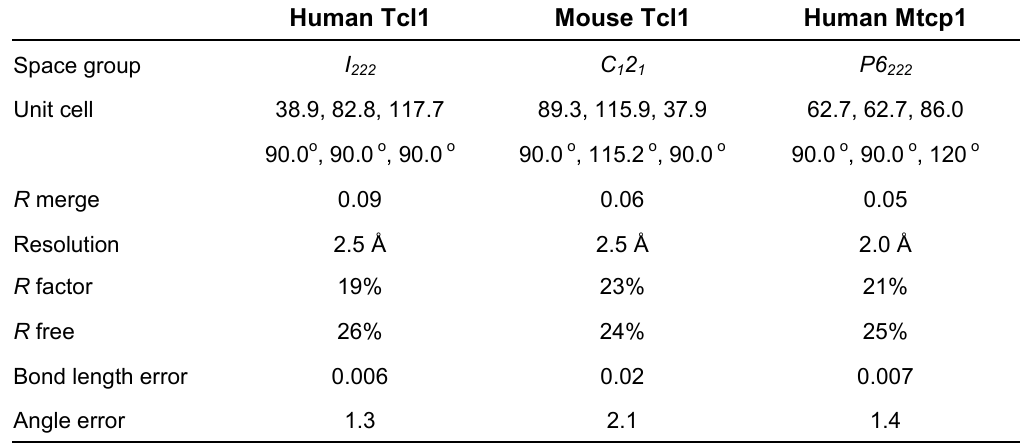
Crystallographic Statistics for Human Tcl1, Mouse Tcl1, and Human Mtcp1 Structures